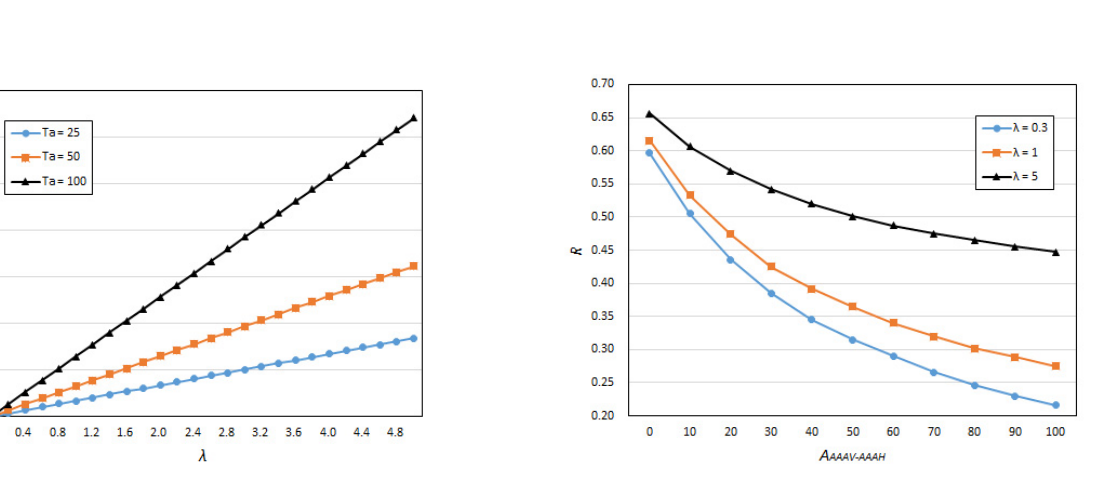
). AAAV (cid:0) AAAH = 50